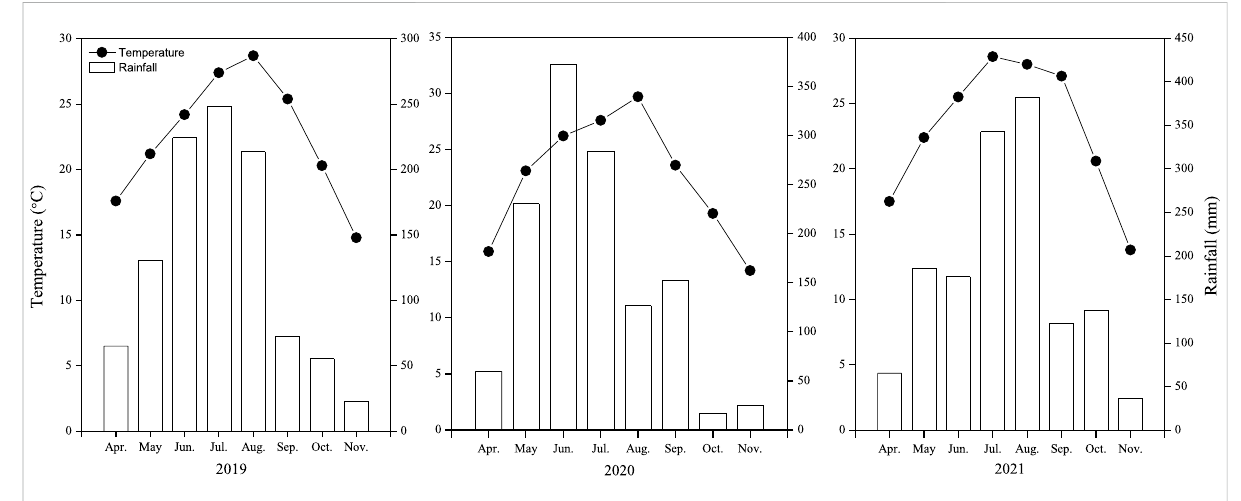
FIGURE 1 The monthly mean rainfall and temperature of early and late rice growing seasons from 2019 to